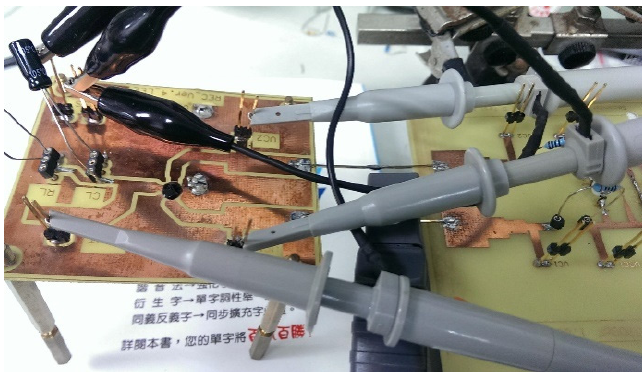
Figure 28. Actual measurement board (IC).